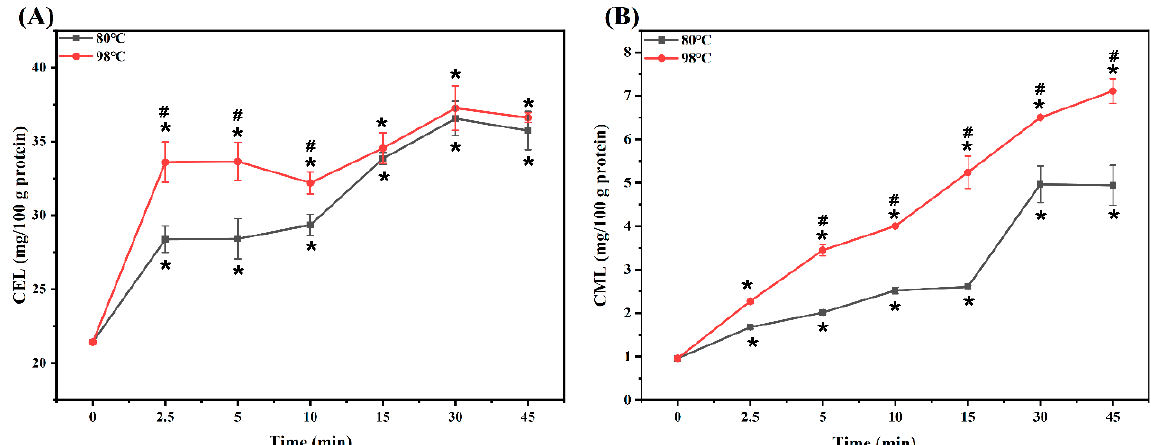
Figure 1. Changes in N ε -carboxyethyl-lysine (CEL) ( A ) and N ε -carboxymethyl-lysine (CML) ( B ) content of myofibrillar protein and glucose (MPG) under different heating conditions (80 °C and 98°C, 0 − 45 min). Error bars indicate standard deviation (n = 3). Samples with * p < 0.05 indicate significant differences at different heating times (compared with 0 min). Samples with # p < 0.05 indicate significant differences between 80 °C and 98 °C.